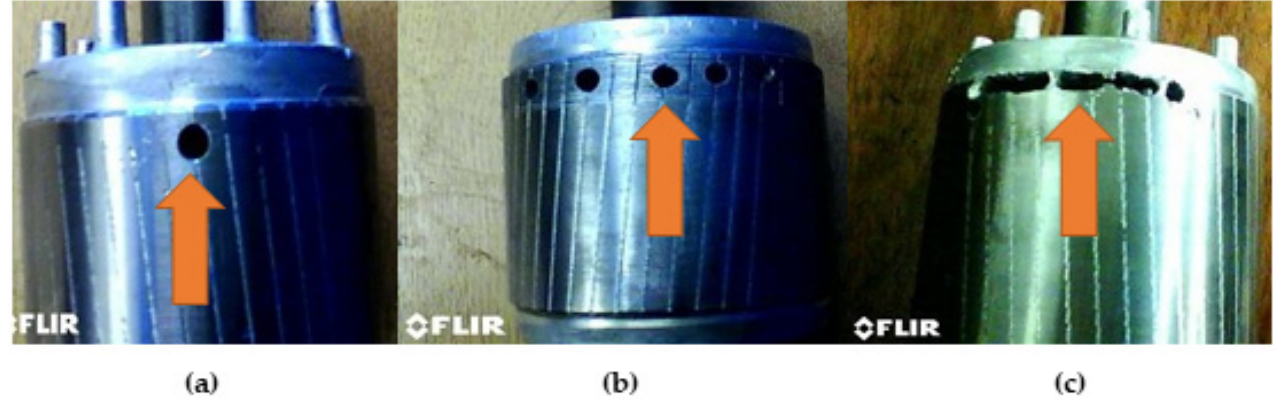
Figure 4. Rotor faults. ( a ) One-Broken Rotor Bar fault; ( b ) Five-Broken Rotor Bar fault; ( c ) Eight- Broken Rotor Bar fault.